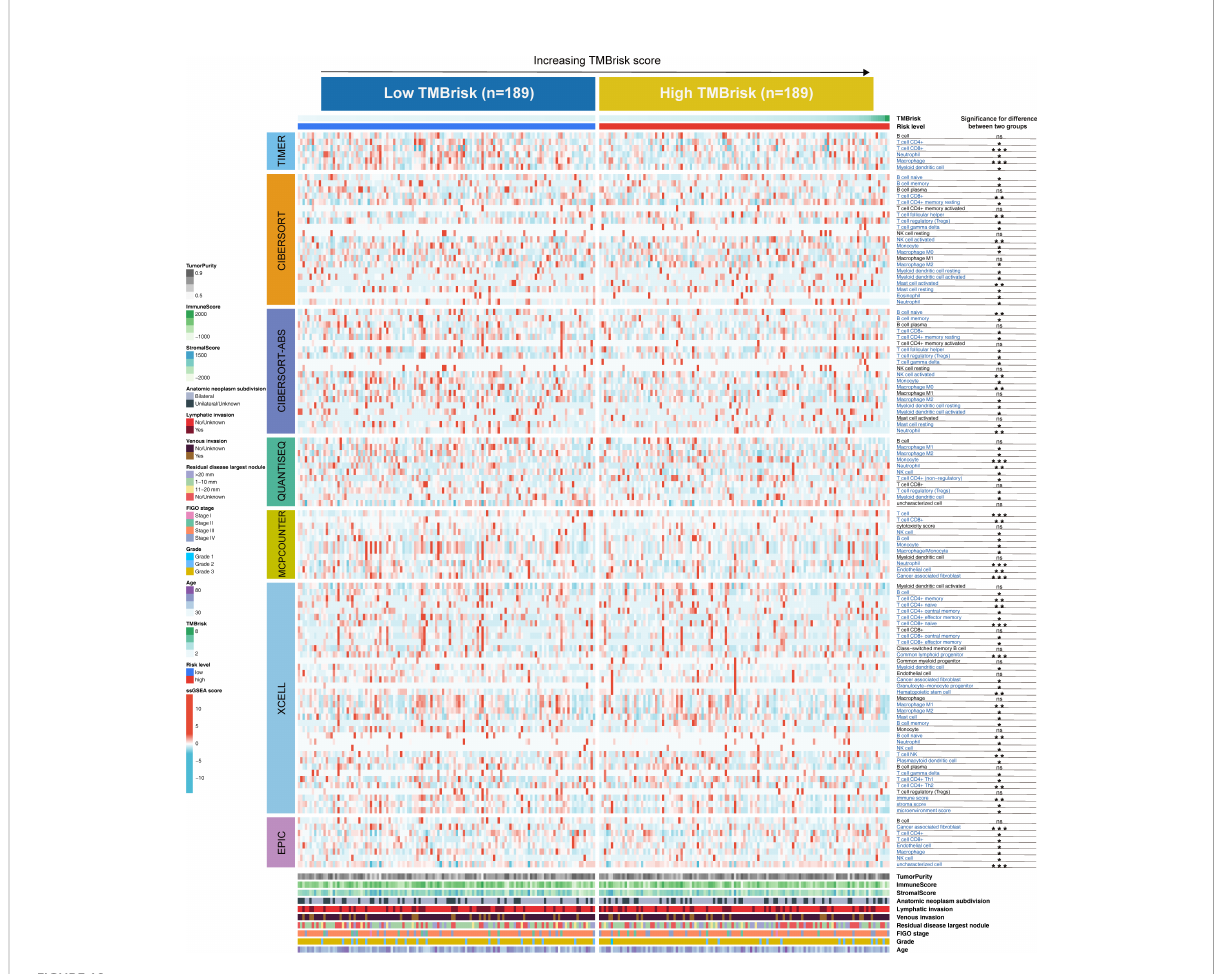
FIGURE 10 Landscape of immune and stromal cell in fi ltrations in the low- and high-TMBrisk groups. Heatmap showing the normalized scores of immune and stromal cell in fi ltrations. The statistical difference between the two groups was compared by the Wilcoxon test. *p < 0.05; **p < 0.01; ***p < 0.001. The clinical features of the patients were also described as